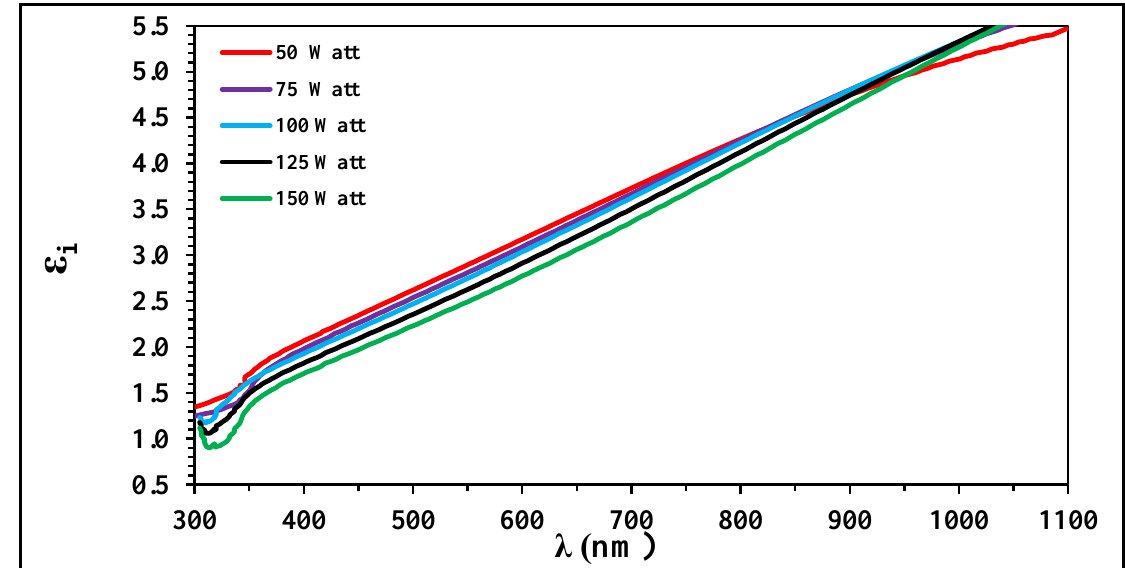
Fig.7: Dielectric constant imaginary as a function of wavelength for (Ti6Al4V) thin film at different working RF powers.